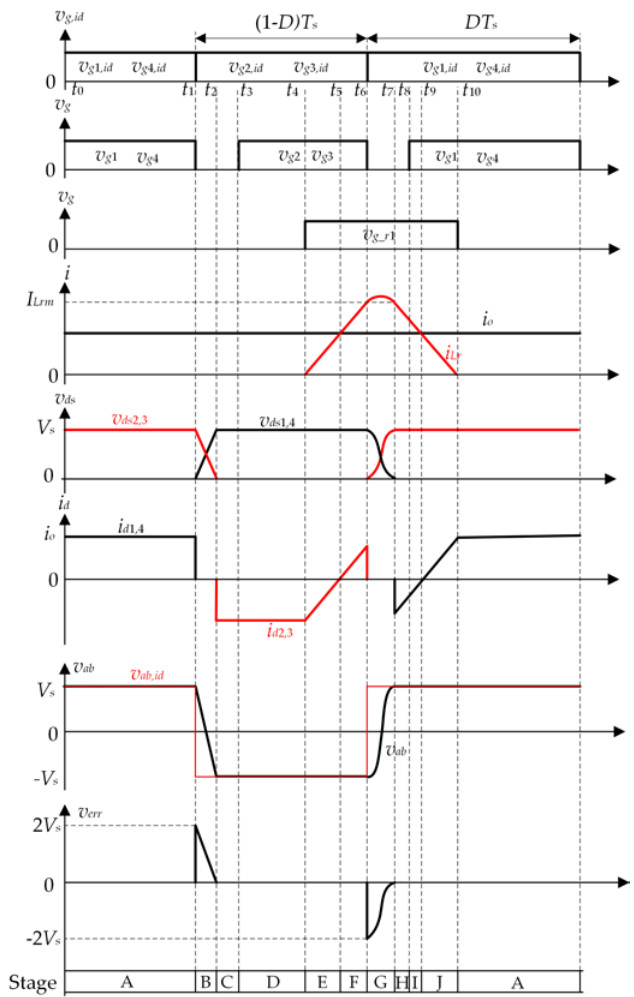
Figure 3. The key waveforms of the ARSI when the output current is positive.